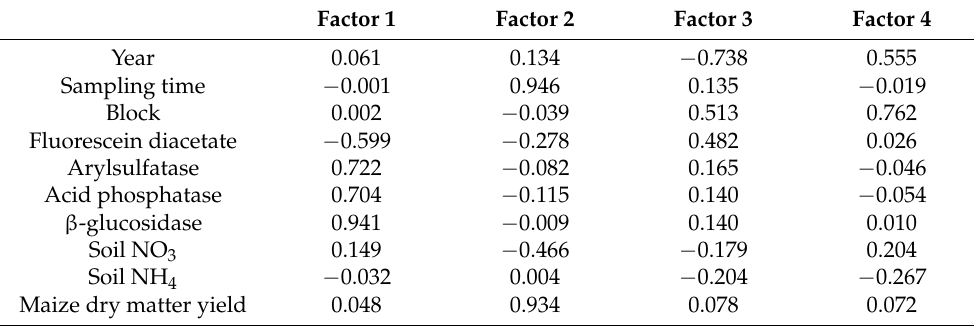
Table 8. Component matrix by factor analysis for soil enzyme activity, soil nitrogen, and maize dry matter yield.